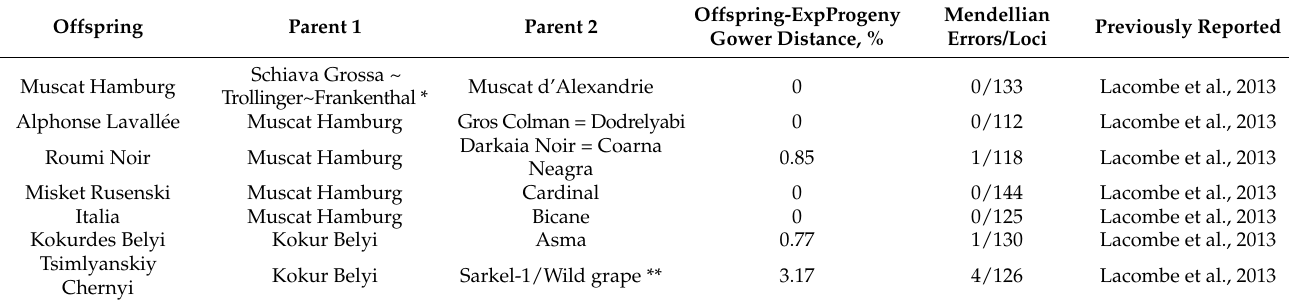
Table 3. Supposed novel and confirmed trios of V. vinifera varieties.